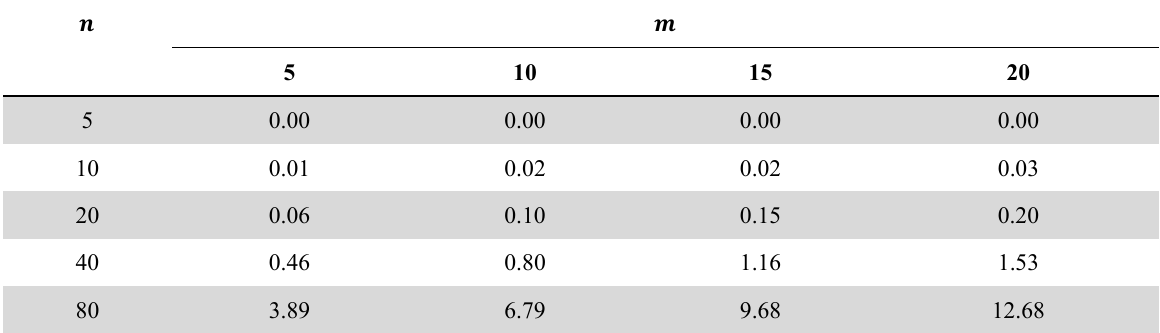
execution (cid:3021)(cid:3021)(cid:3015)